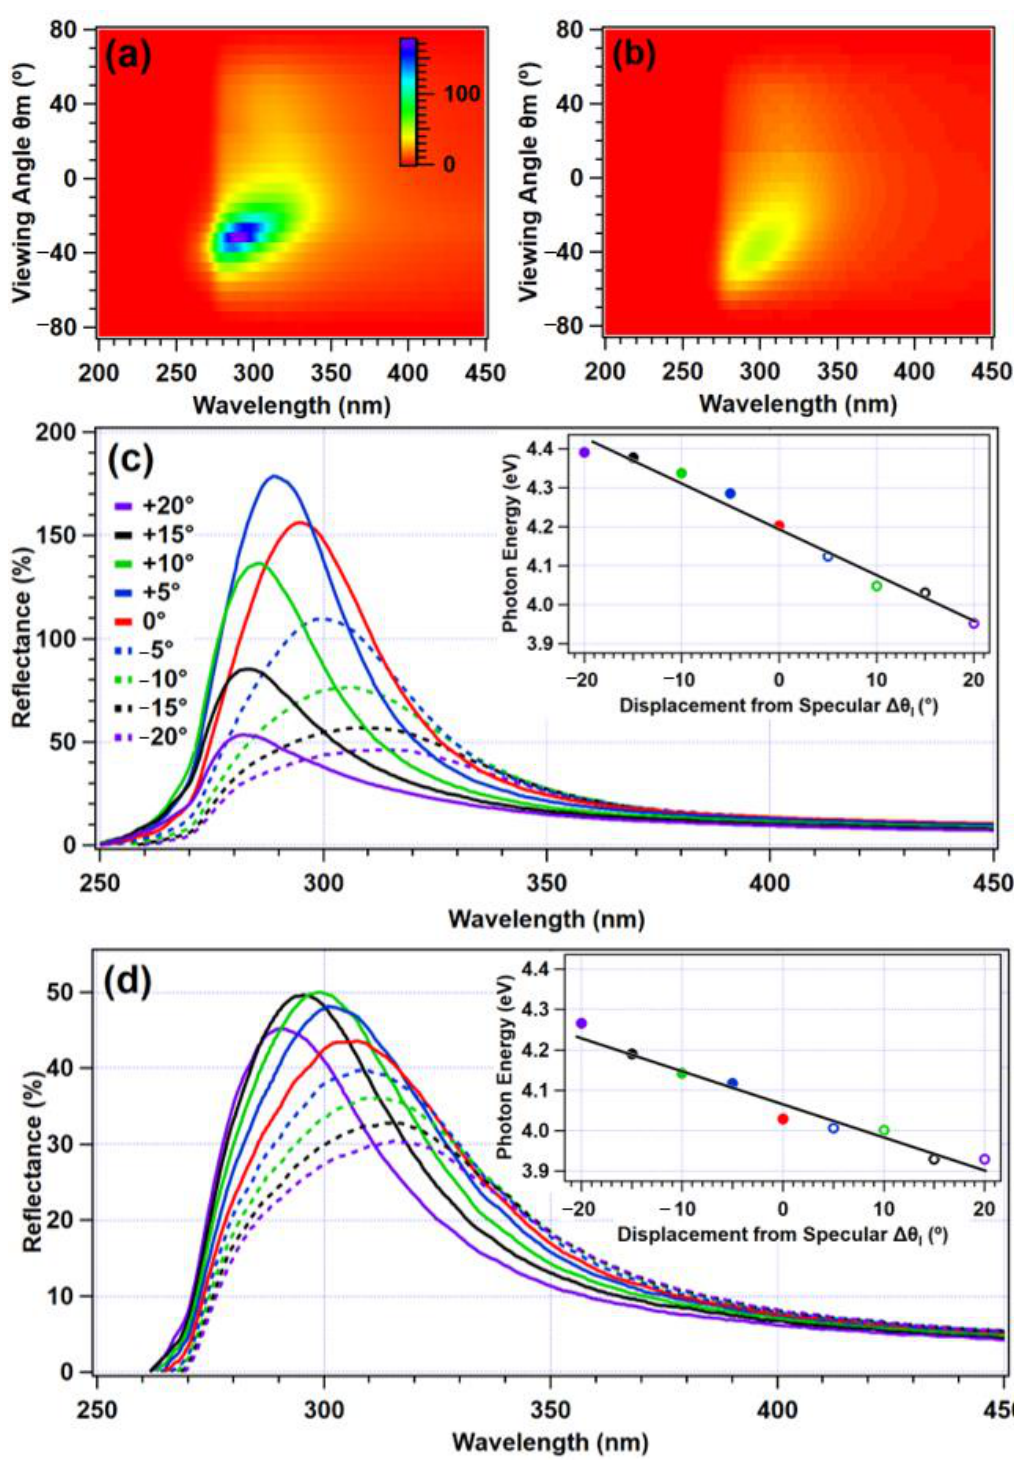
Figure 5. Scattering cones of a 40-shear pass polymer opal, illuminated at 30° from the zenith for ( a ) ϕ m = 30° and ( b ) ϕ m = 60°, with reflectance on the z -axis with scale inset in ( a ). The reflectance spectra for viewing angles between 20° above and 20° below the specular direction in 5° increments are shown in ( c ) for the ϕ m = 30° orientation and in ( d ) for ϕ m = 60°. The wavelengths of the peak intensity for each viewing angle were extracted and are displayed (insets) in terms of photon energy, with the dots and hoops corresponding to the solid and dashed lines, respectively.